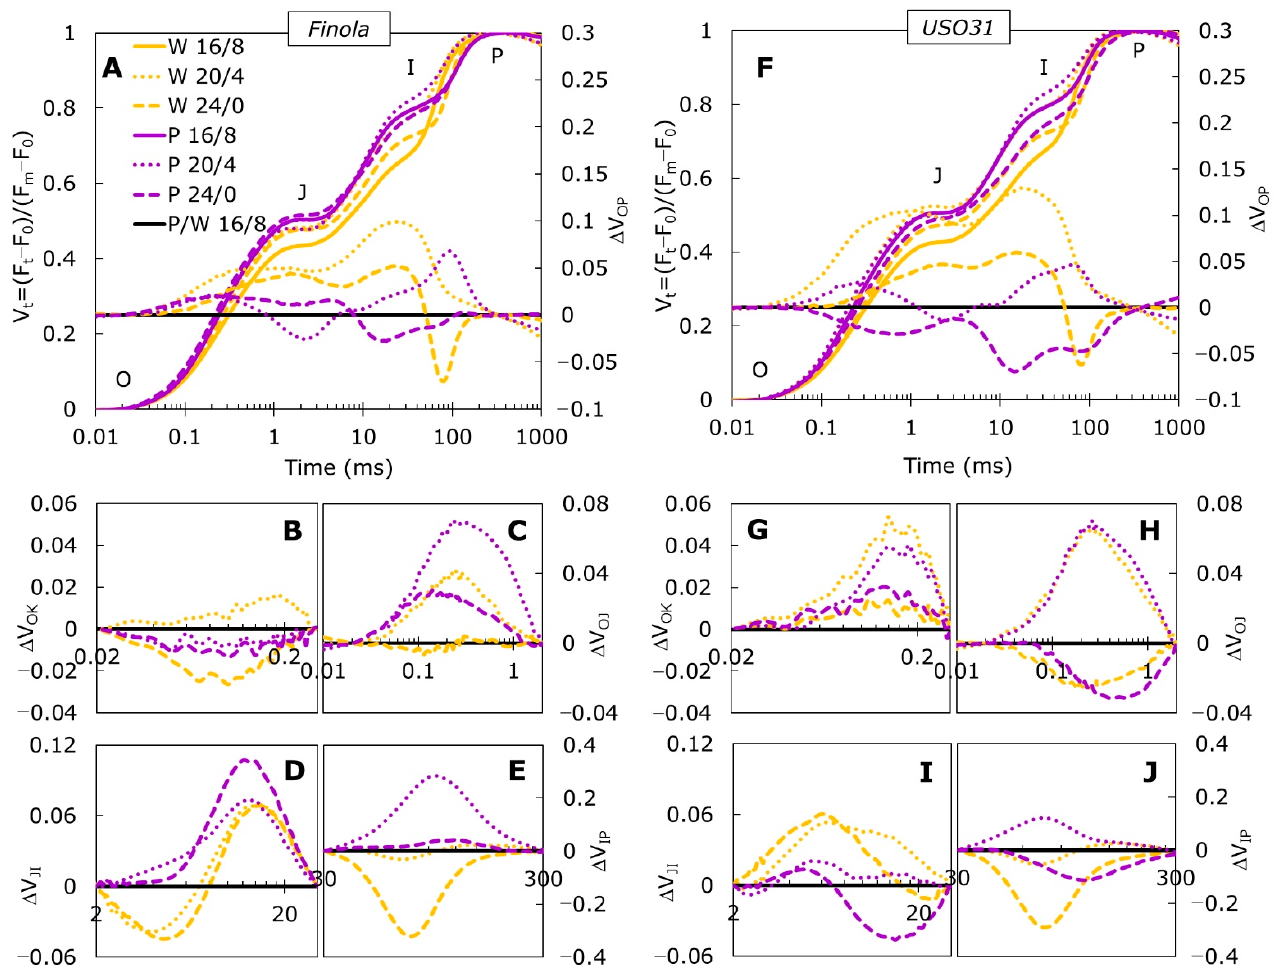
Figure 1. Differences in the shapes and amplitudes of OJIP transient curves measured in Cannabis cultivars Finola and USO31 exposed to 16/8, 20/4, and 24/0 photoperiods and grown under white and purple light are presented as kinetics of relative variable fluorescence V t and as difference kinetics Δ V OP ( A , F ). Difference kinetics Δ V t , for individual bands, L ( B , G ), K ( C , H ), H ( D , I ), and G ( E , J ) are plotted at different time ranges. Each curve represents the average of five measurements (n = 5) per treatment. The 16/8 photoperiods were used as referent values for each cultivar and growth light. The O, J, I, and P steps are indicated in Vt curves.